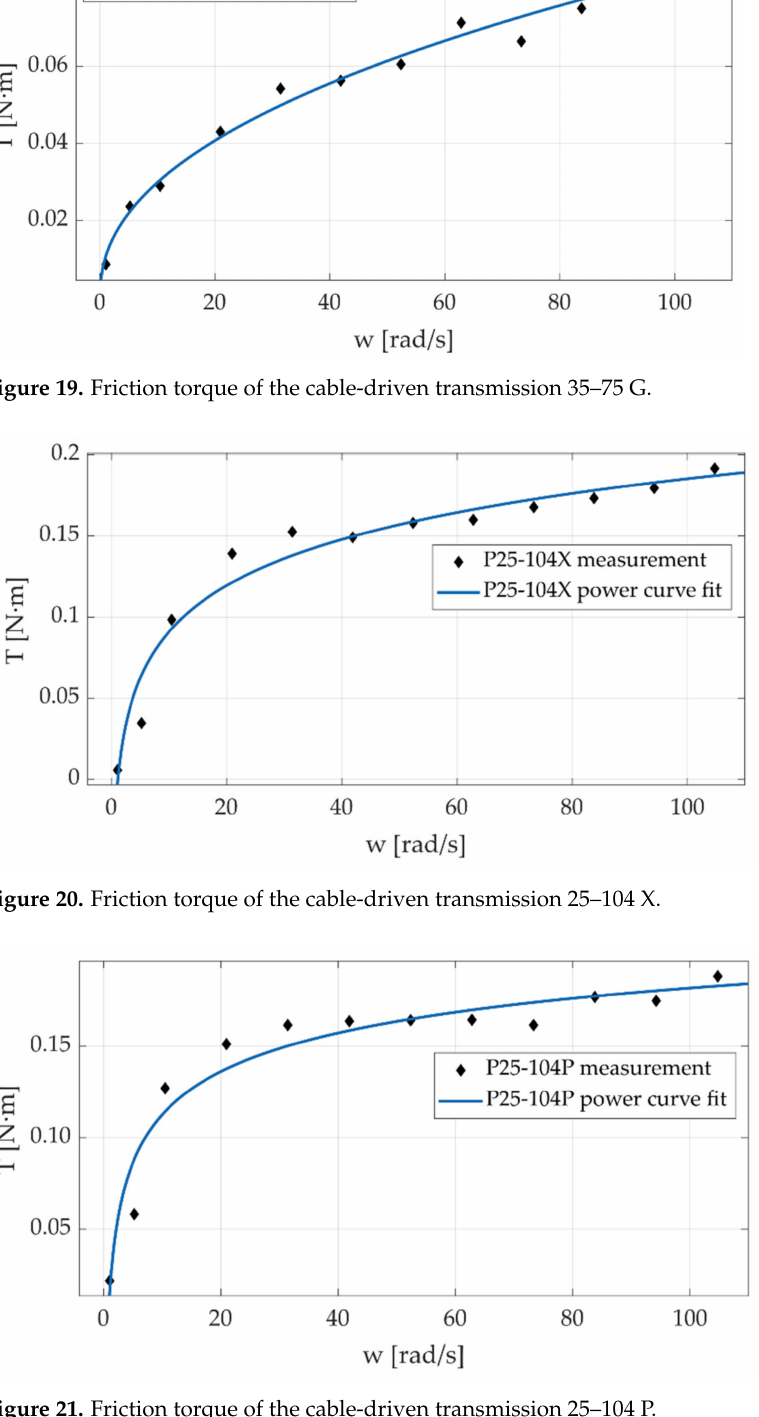
Figure 21. Friction torque of the cable-driven transmission 25–104